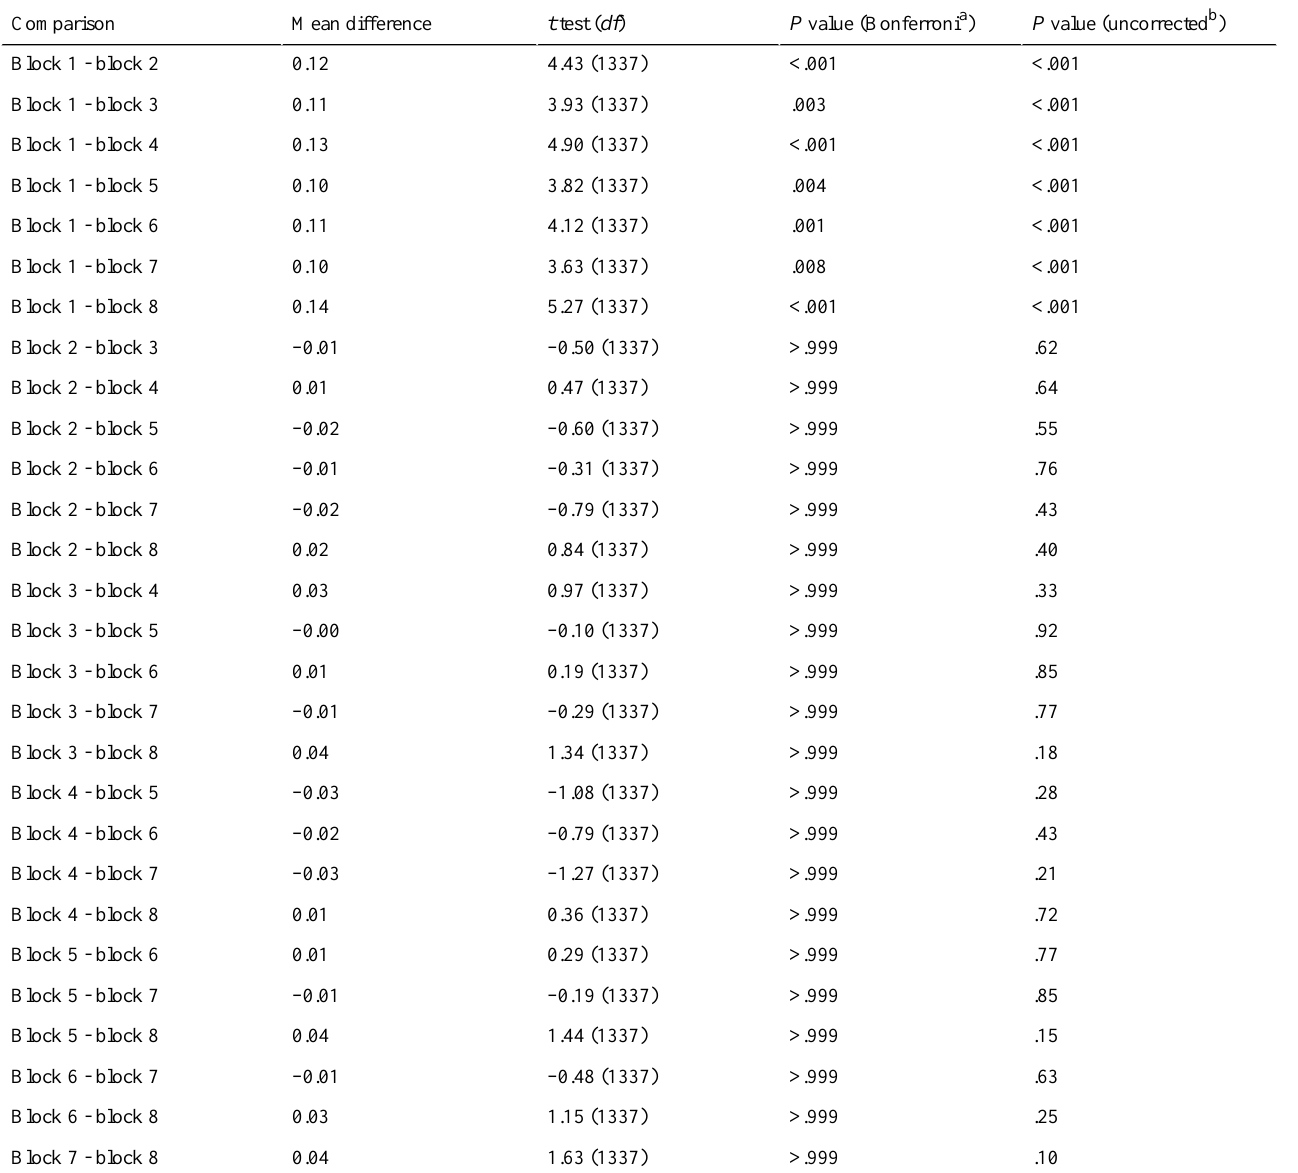
Table 2. Posthoc